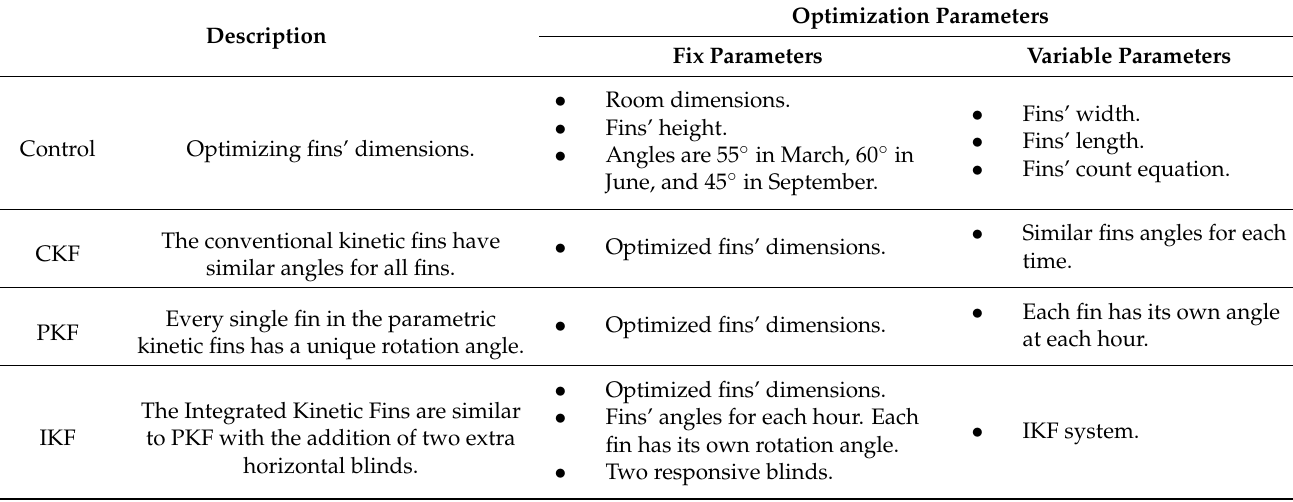
Table 1. Optimization process of the kinetic fins.